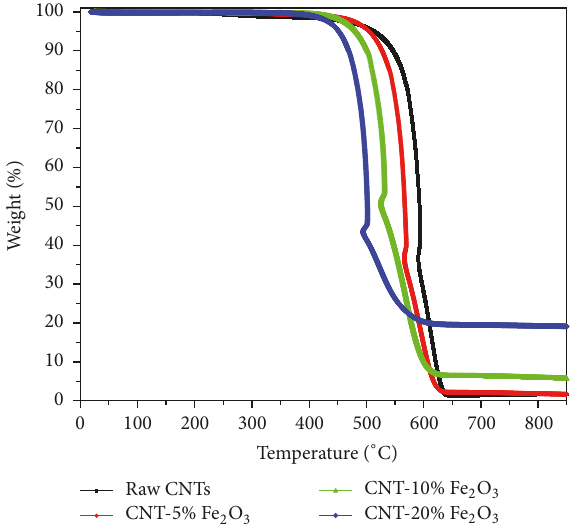
Figure 6: Zeta potential of raw CNTs and CNTs impregnated with 1%, 10%, and 20% Fe 2 O 3 .